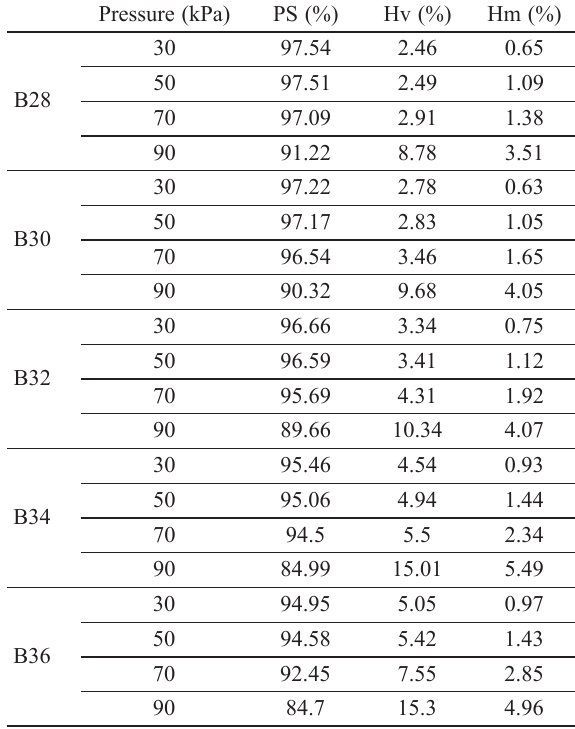
Table 5. Composition of real interstitial mediums of each concrete Pressure (kPa)